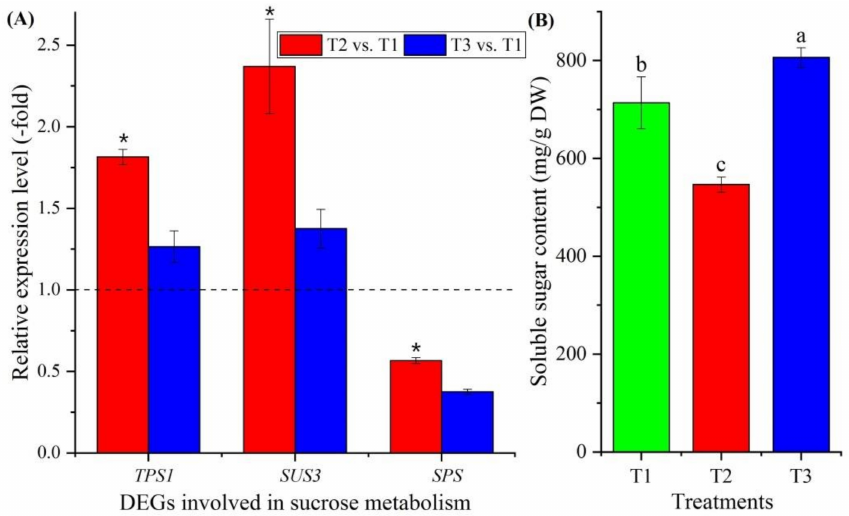
Figure 7. Expression levels of 3 genes involved in sucrose metabolism at T2 vs. T1 and T3 vs. T1 ( A ), and changes in soluble sugars contents at T1, T2 and T3 ( B ). Here and below, “*” represents a significant difference at the p < 0.05 level between T2 vs. T1 and T3 vs. T1 for the same gene; the use of different letters represents a significant difference ( p < 0.05) at different temperature